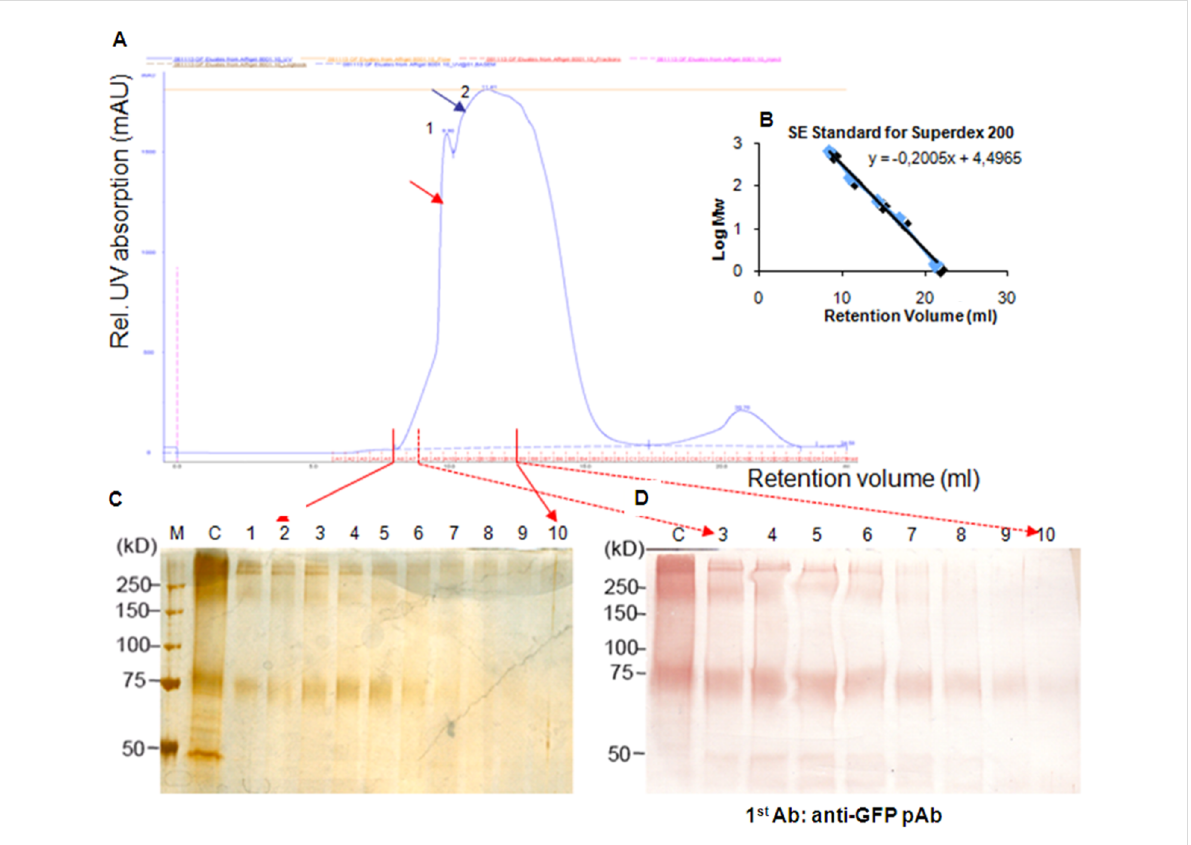
Figure 4: Purification of the GAT1/GFP fusion protein from Sf 9 cells by SE-FPLC. (A) Elution profile of GAT1/GFP after SE-FPLC on a Superdex 200 TM column. (B) The standard linear regression curve of the Superdex 200 TM column was generated by plotting the log of the molecular masses of different calibration proteins against their elution volumes. (C), (D) Silver staining and Western blotting of the SDS-PAGE (7.5%) results of eluted frac- tions (from 8.8 to 11.8 mL) after SE-FPLC. M: standard marker; C: concentrated sample from immunoaffinity column; 1–10: SE-FPLC fractions from 8.8 to 10.8